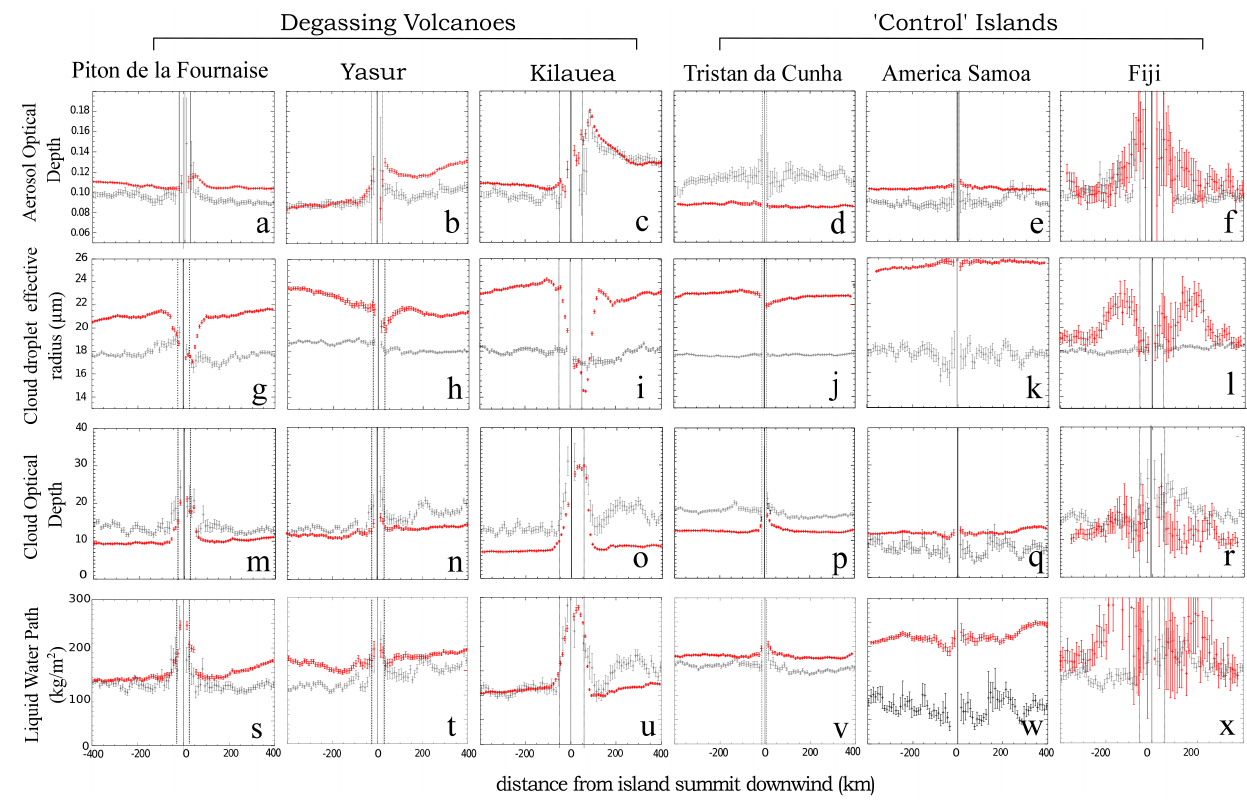
Figure 8. Comparison of multiannual averages for AATSR (grey) and MODIS (red) data, presented as in Fig. 3 and